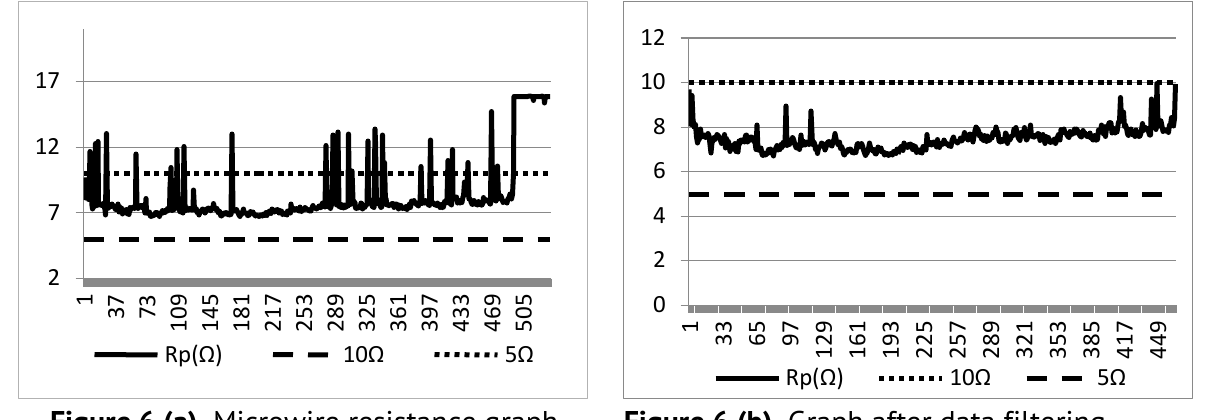
Figure 6 (b). Graph after data filtering.